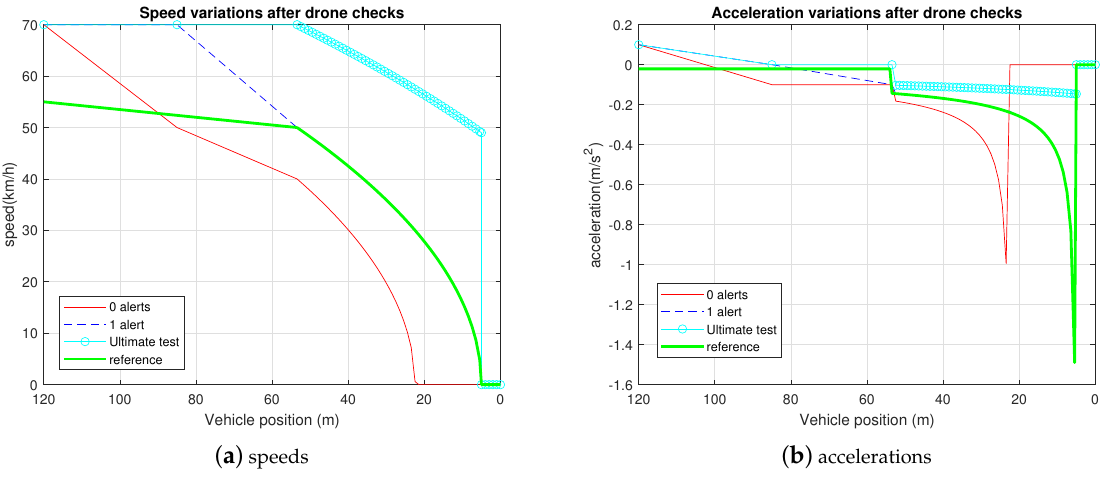
Figure 13. Speeds and accelerations of driver type 2, case of wet curved